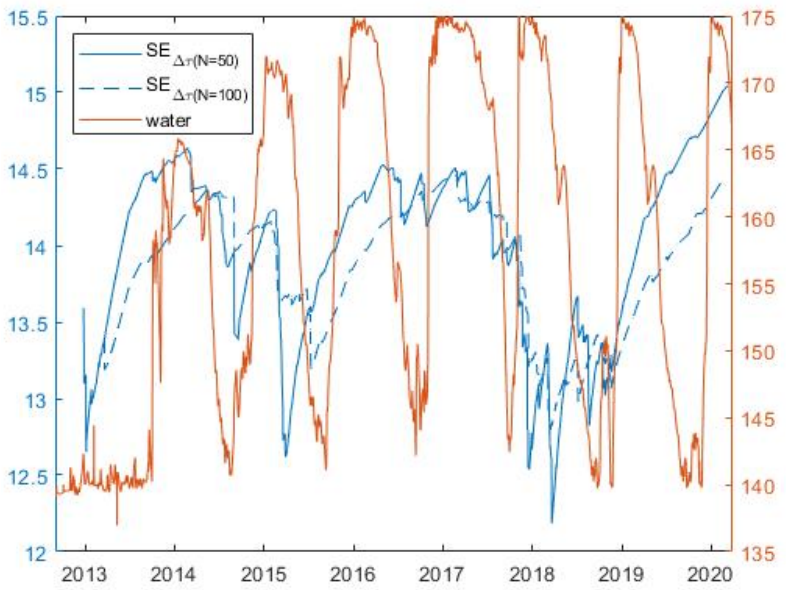
Figure 2. SE of Δ τ for the whole seismic catalogue (blue) and water level (red). Two different lengths of moving windows have been selected for calculating SE: N = 50 (solid) and N = 100 (dashed).